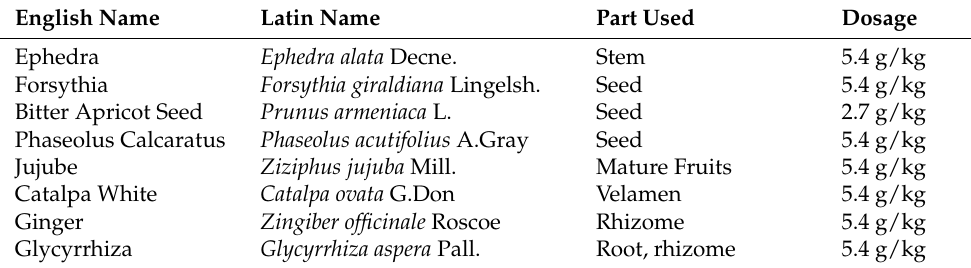
Table 1. The ingredients of the herbal formula